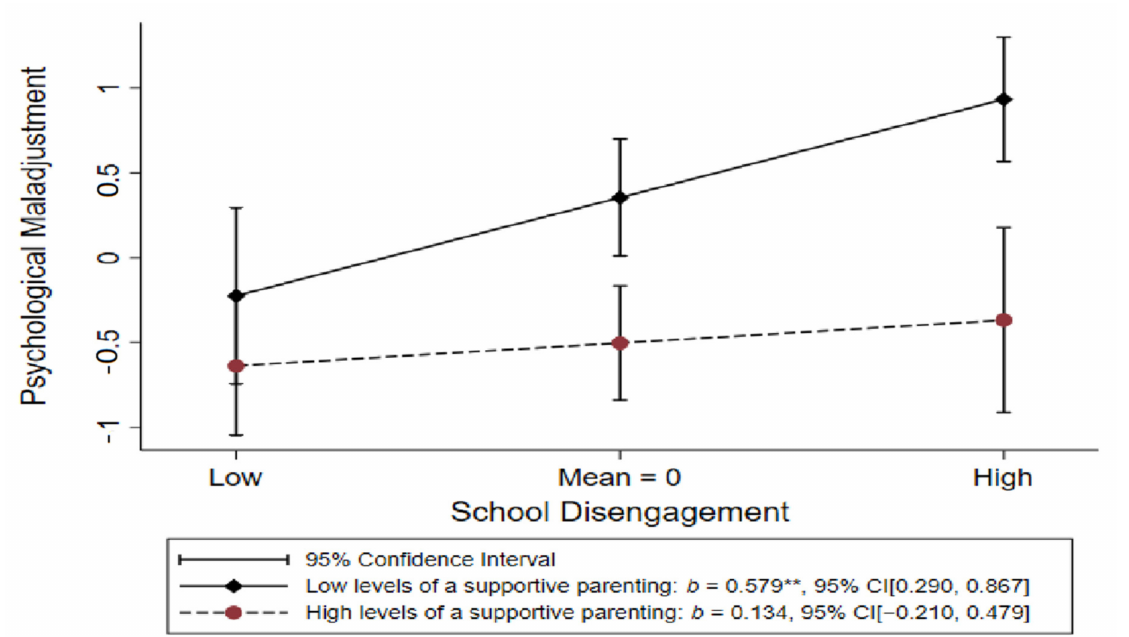
Figure 2. The simple slope test of school disengagement on psychological maladjustment by level of supportive parenting. The lines represent the low (i.e., one SD below the mean) and high (i.e., one SD above the mean) levels of supporting parenting. ** p ≤ 0.01, * p ≤ 0.05, (two-tailed